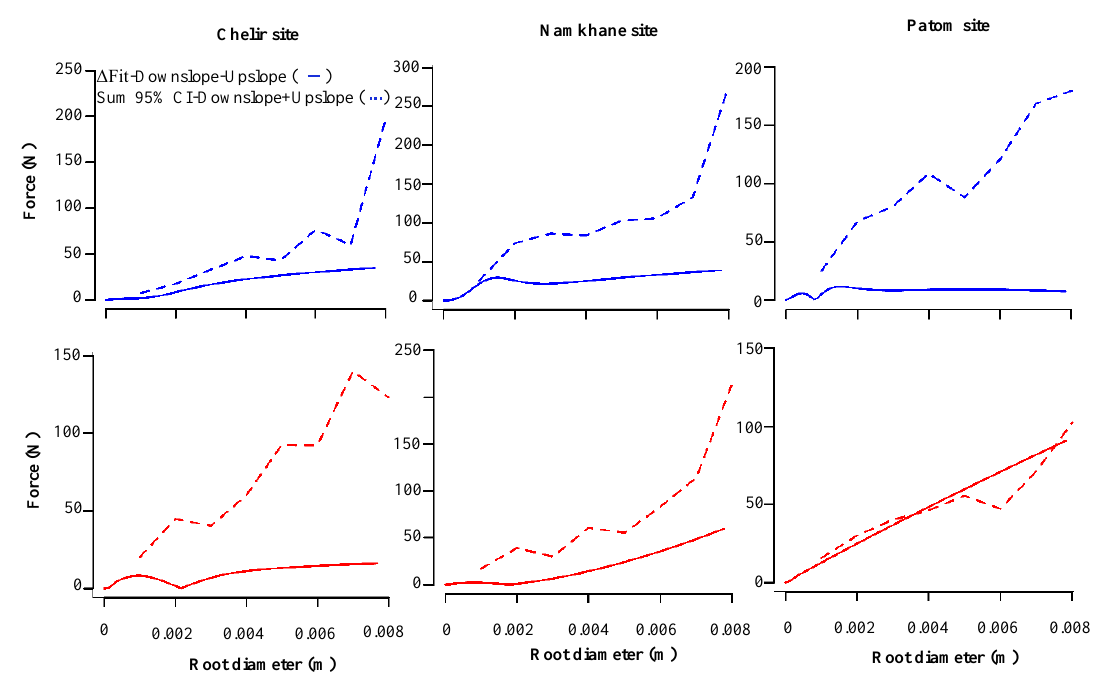
Figure 7. Calculation of difference between the fitting curves of tensile force vs. root diameter for the Carpinus betulus (blue line) and Fagus orientalis (red line) at three study sites (Chelir, Namkhane, Patom).